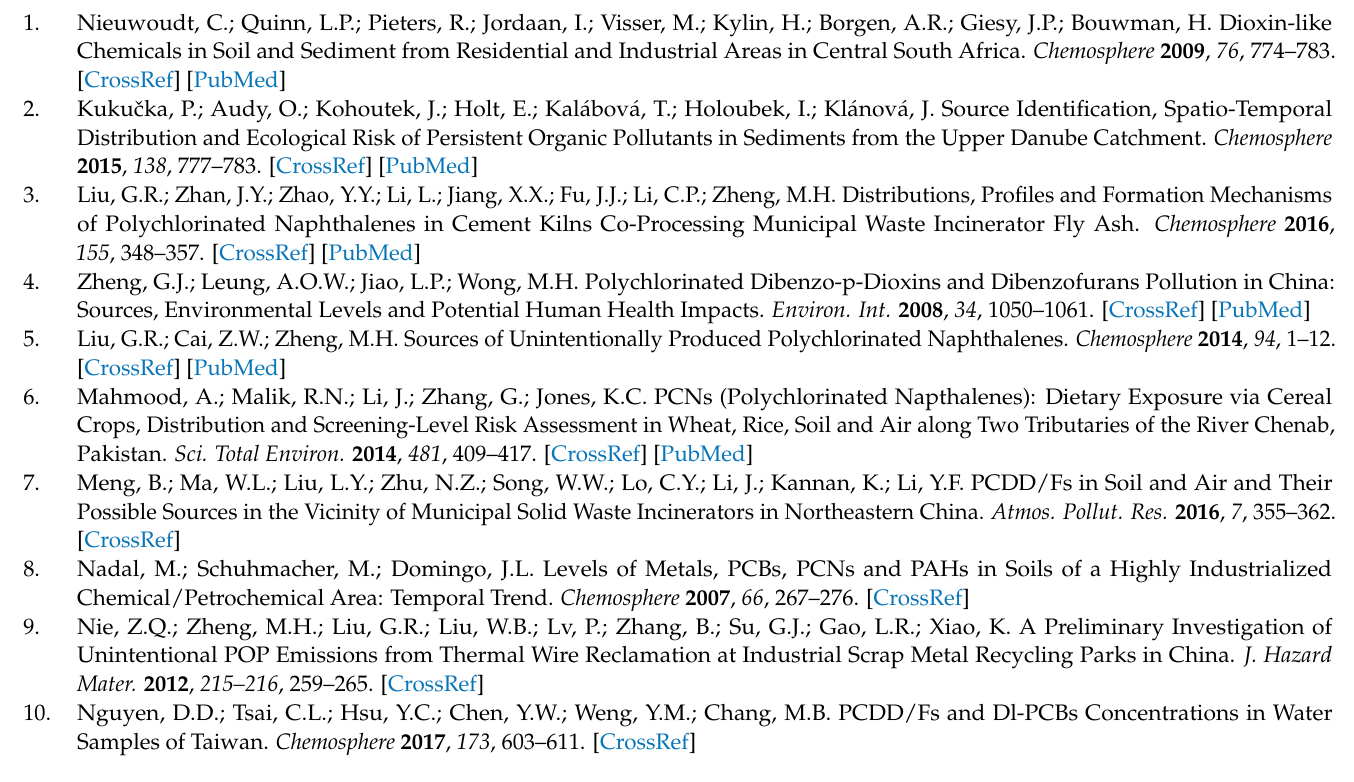
Table S4: Compound specific parameters used in the health risk assessment; Table S5: Pearson correlation coefficients for the relationships between the soil and fly ash samples of PCN, PCB and PCDD/Fs homologs; Table S6: Carcinogenic risks (CR) and non-carcinogenic risks (no-CR) near by the cement kilns co-processing municipal waste; Table S7: Proportions of carcinogenic risk (CR) and non-carcinogenic risks (no-CR) in different pathways